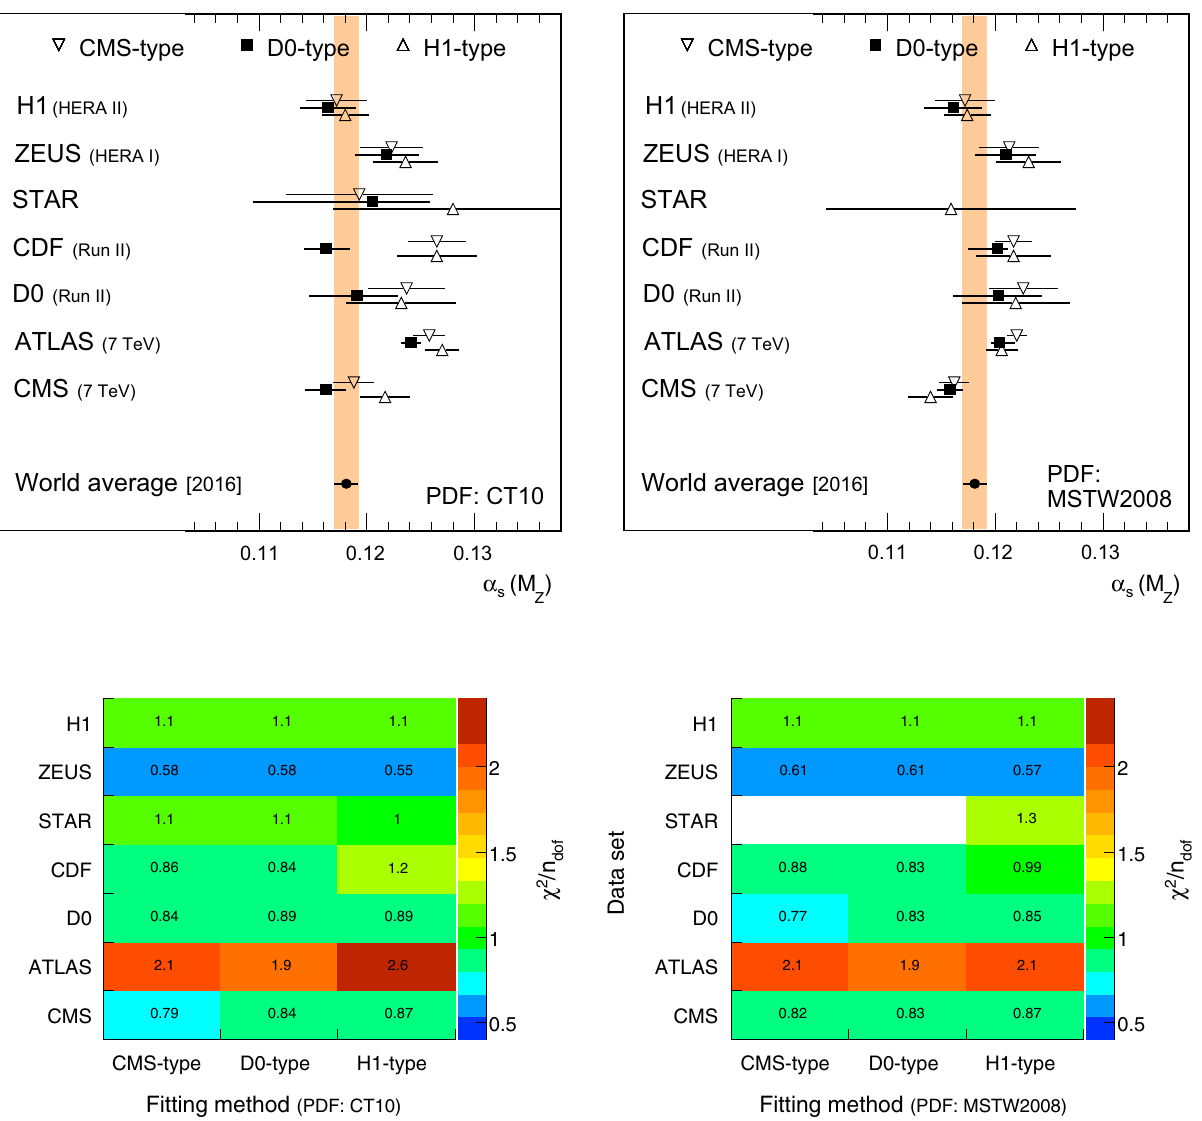
Fig. 1 Values of α s ( M Z ) with experimental uncertainties obtained using the three extraction methods CMS-type, D0-type, and H1-type. TheupperrowcomparestheresultsforeachdatasetemployingthePDF set CT10 (left) or MSTW2008 (right). In addition, the world average value [1] is shown together with a band representing its uncertainty. The